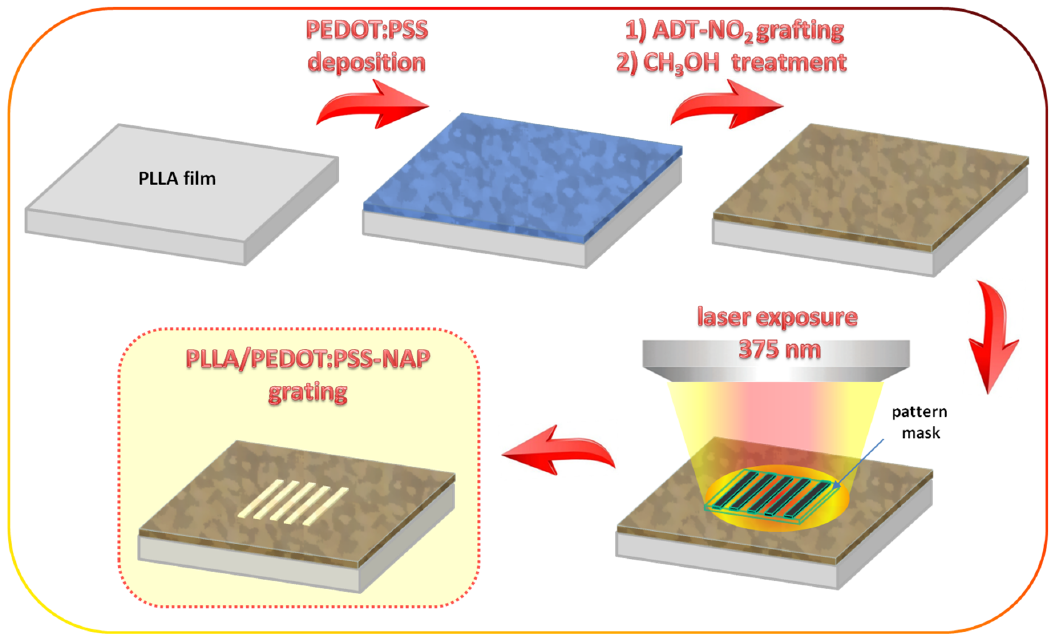
Figure 1. Schematic representation of experimental concept: thin PEDOT:PSS film was deposited on flexible PLLA substrate, modified by ADT-NO 2 and treated in vapor of methanol; sample illumination with light-emitting diode (LED) was performed through the lithographic mask.